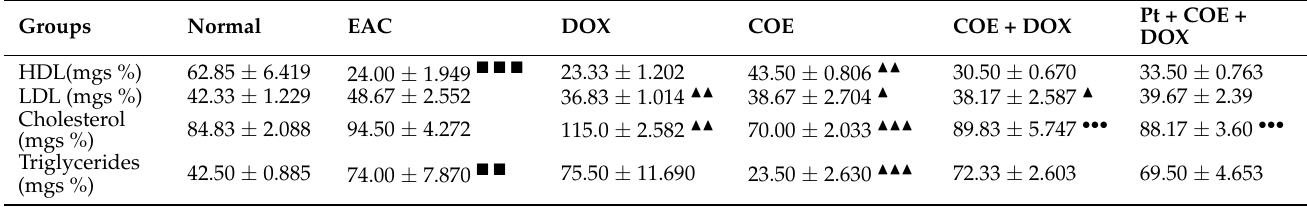
Table 6. Effect of COE on lipid profile.